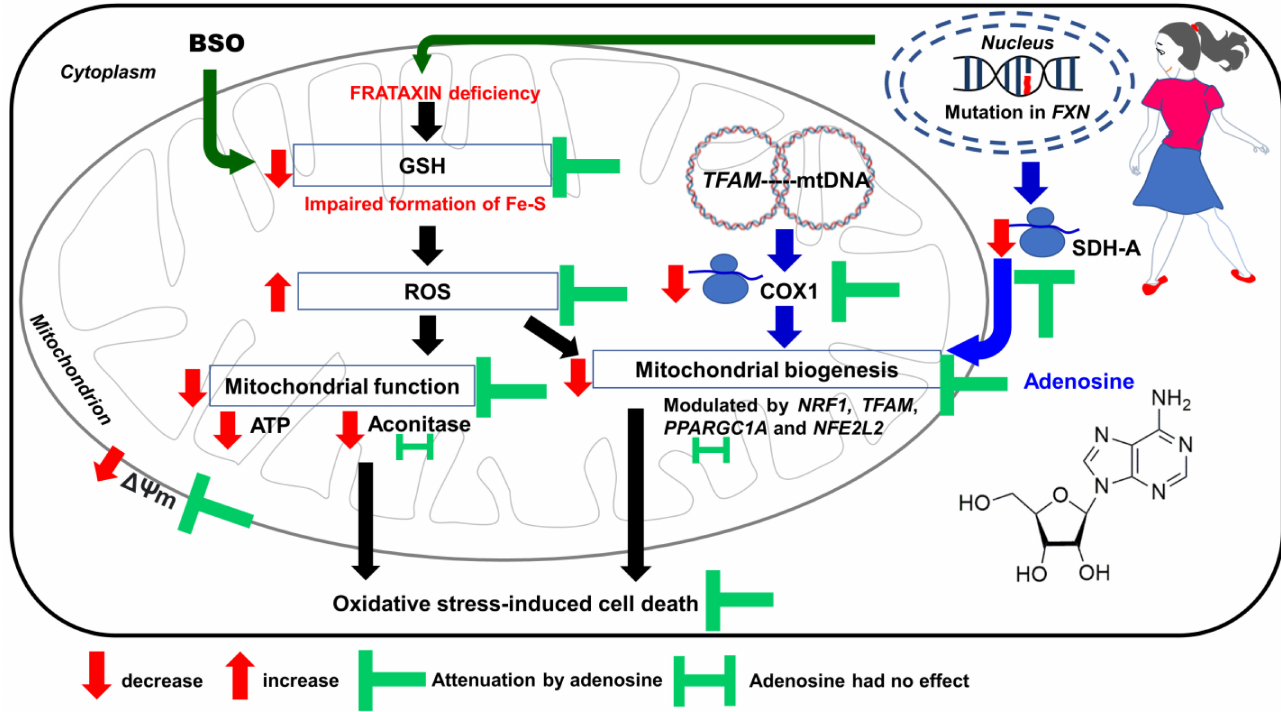
Figure 7. Proposed mechanism in which adenosine improves mitochondrial function and biogenesis in FRDA fibroblasts following BSO-induced oxidative stress. Illustration was created using Microsoft PowerPoint Professional Plus 2019. ATP, adenosine triphosphate; BSO, L-buthionine sulfoximine; COX1, cytochrome c oxidase subunit 1; Fe-S, iron–sulfur; FXN , frataxin; GSH, glutathione;